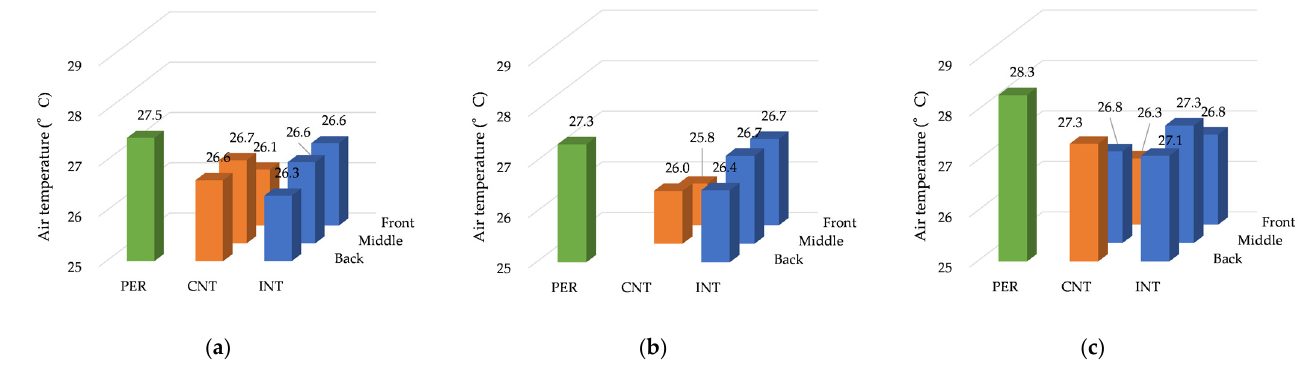
Figure 27. Summer average air temperature in ( a ) class A, ( b ) class B, and ( c ) class C.